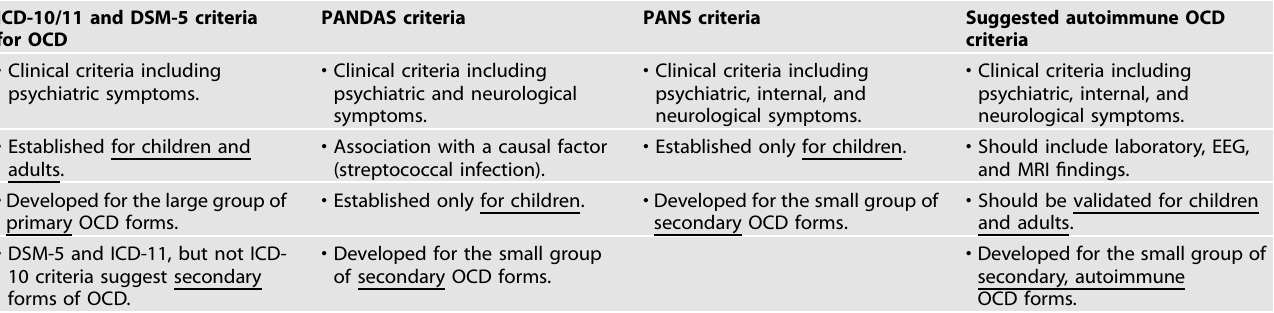
Table 5. Diagnostic criteria following ICD-10/11 and DSM-5 in comparison with PANDAS/PANS and suggested autoimmune OCD criteria [9,34, https://www.who.int/classi fi cations/icd/en/GRNBOOK.pdf; https://icd.who.int/browse11/l-m/en#/http%3a%2f%2 fi d.who.int%2 fi cd%2fentity% 2f1126473669].